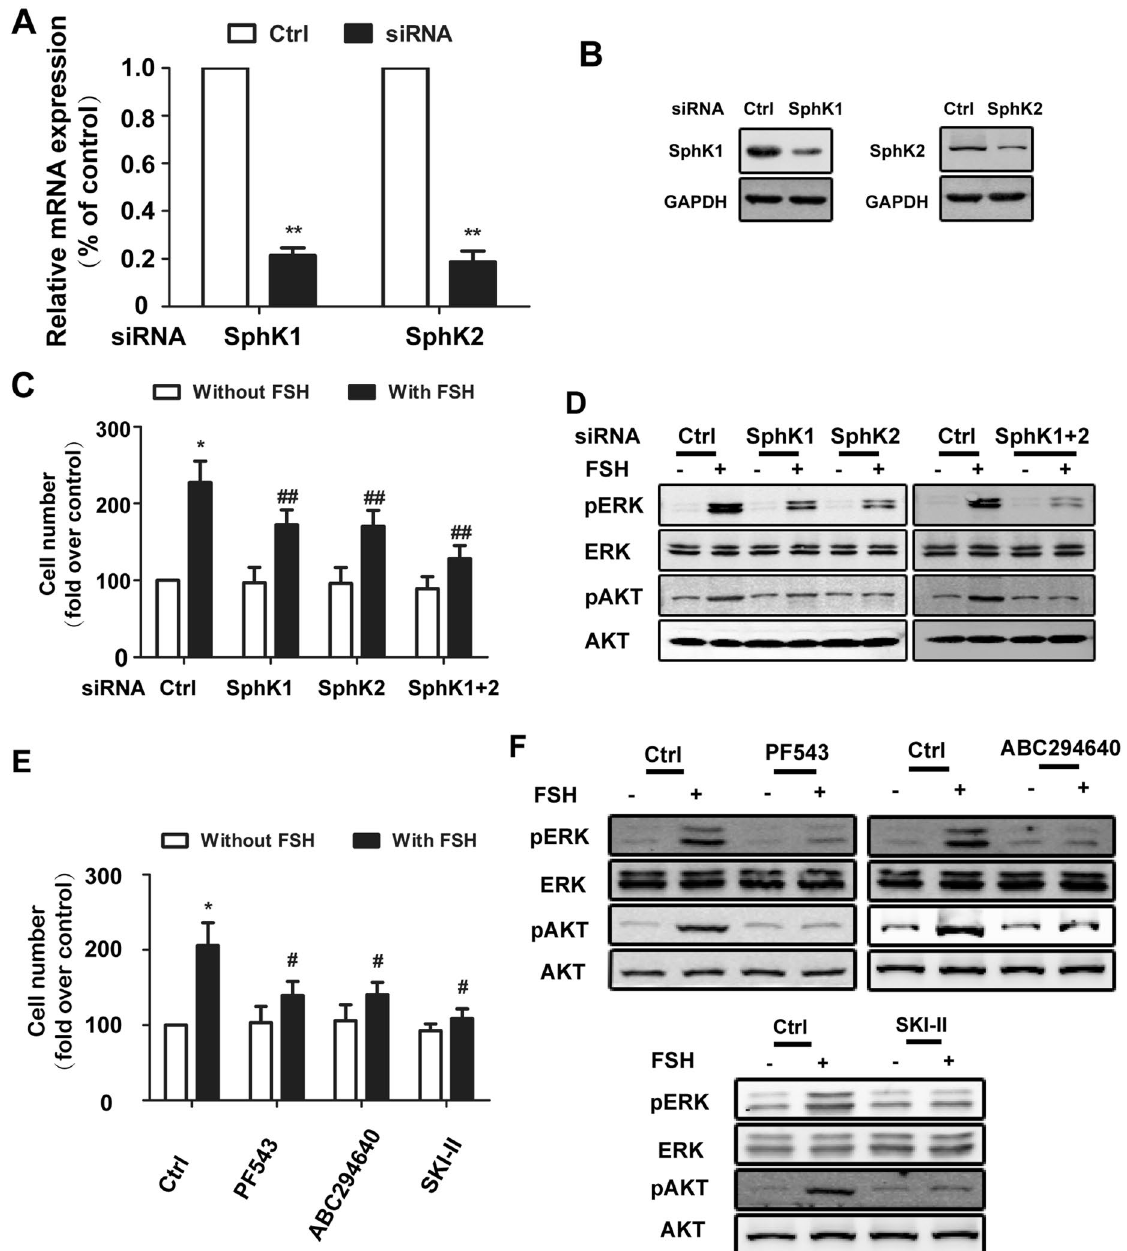
Figure 5. SphK1 and SphK2 played equal roles on cell proliferation stimulated by FSH. ( A ) HO8910 cells were transfected with control siRNA or siRNA targeting SphK1 or SphK2. After 24 h of transfection, mRNA levels of SphK1 and SphK2 were determined by quantitative RT-PCR. Data are expressed as the change with respect to control siRNA. ( B ) After 48 h of transfection, protein levels of SphK1 and SphK2 were determined by immunoblotting analysis and normalized to GAPDH. The data were expressed as changes relative to the control siRNA. ( C ) Having been transfected with the different siRNA, HO8910 cells were cultured with or without FSH (40 mIU/ml). After 72 h, cell survival ability was detected. ( D ) HO8910 cells transfected with specific siRNA were treated with FSH (40 mIU/ml) for 30 min. Phosphorylated-Erk (pErk) and phosphorylated Akt (pAkt) were observed by Immunoblotting analysis. ( E ) Serum-starved HO8910 cells were pretreated by different SphK inhibitors (SKI-II 2.5 µM, PF543 25 µM, ABC294640 50 µM) for 2 h. And then HO8910 cells were cultured with or without FSH (40 mIU/ml). After 72 h, cell survival ability was detected. ( F ) HO8910 cells, having been pretreated with different SphK inhibitors, were treated with FSH (40 mIU/ml) for 30 min. Phosphorylated-Erk (pErk) and phosphorylated Akt (pAkt) were observed by immunoblotting analysis. Data are mean ± SD. * P < 0.05, vs. control/-FSH; # P < 0.05, vs. control/ +